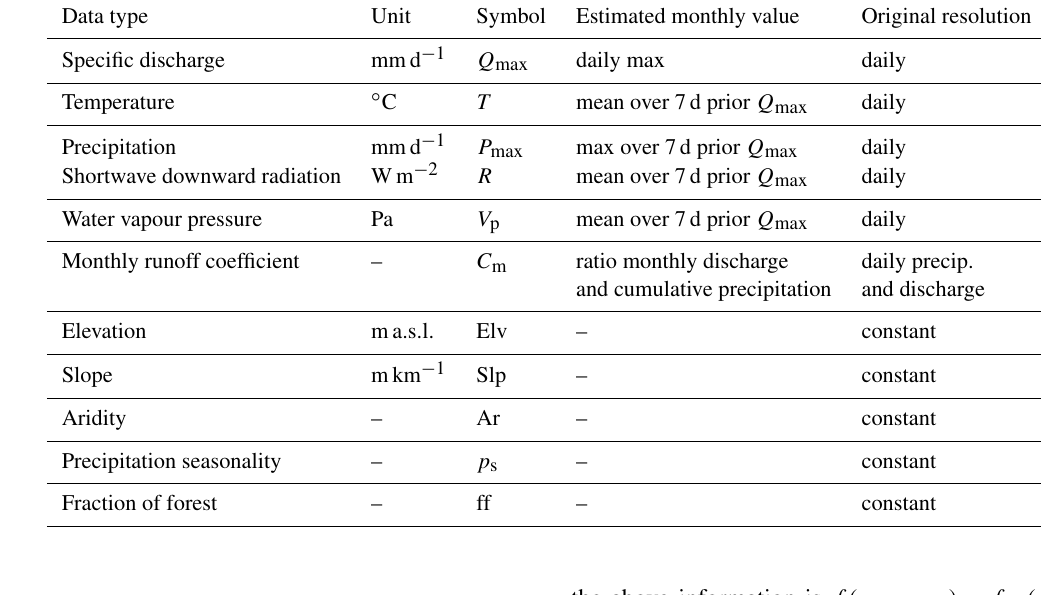
Table 1. Hydro-meteorological data and catchment attributes used in this